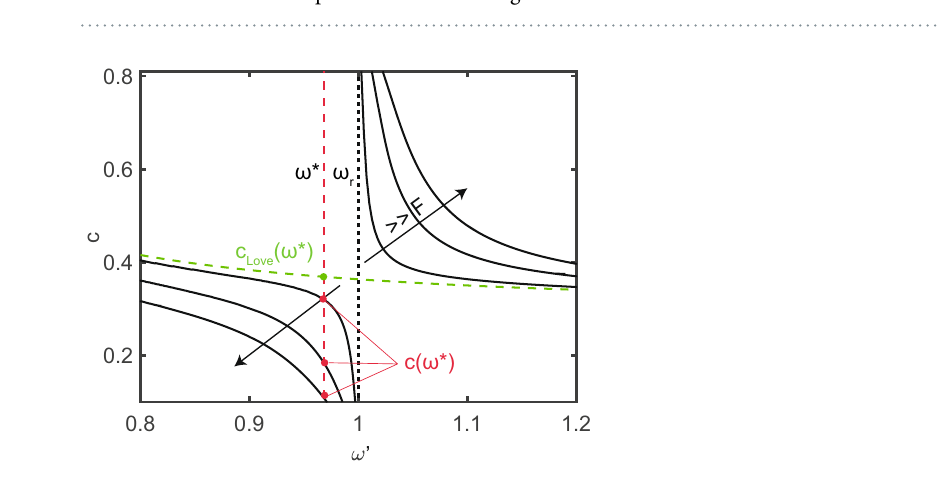
Figure 4. Phase velocities of the zero order Love waves hybridized by a metasurface of horizontal resonators (solid curves) as per Eq. (2) for c T ,2 = 1, α = 0.3, H ′ = 0.848, F = [0.005, 0.025, 0.05]. The dashed green curve corresponds to the zero order Love wave solution.